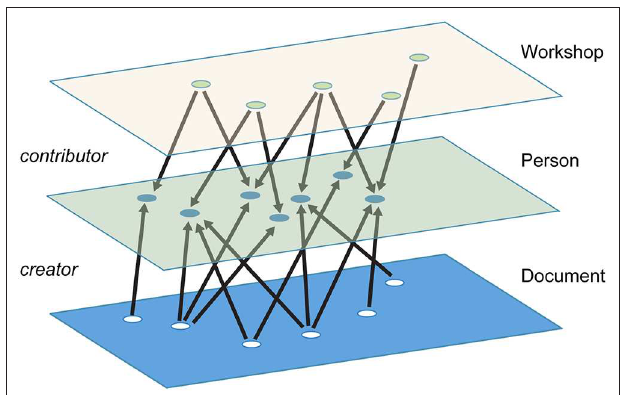
FIGURE 1 | An example of a multidimensional, multipartite network with workshop, person, and document layers. Documents are connected to people by “creator” links, while workshops are connected to people by “contributor”